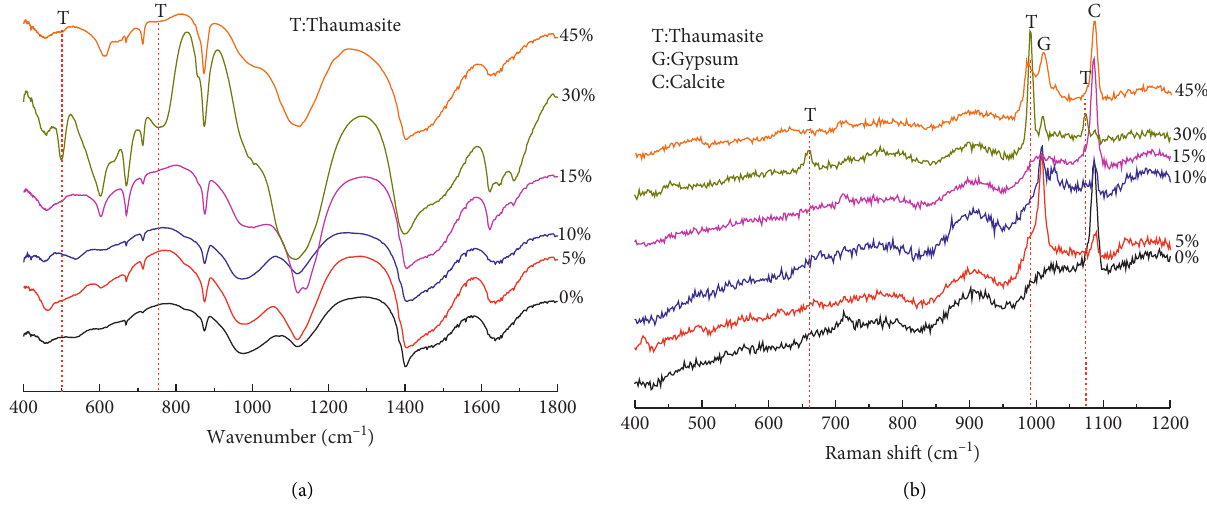
Figure 5: (a) FTIR spectrum and (b) Raman spectrum of the cathode surface for all specimens at 120